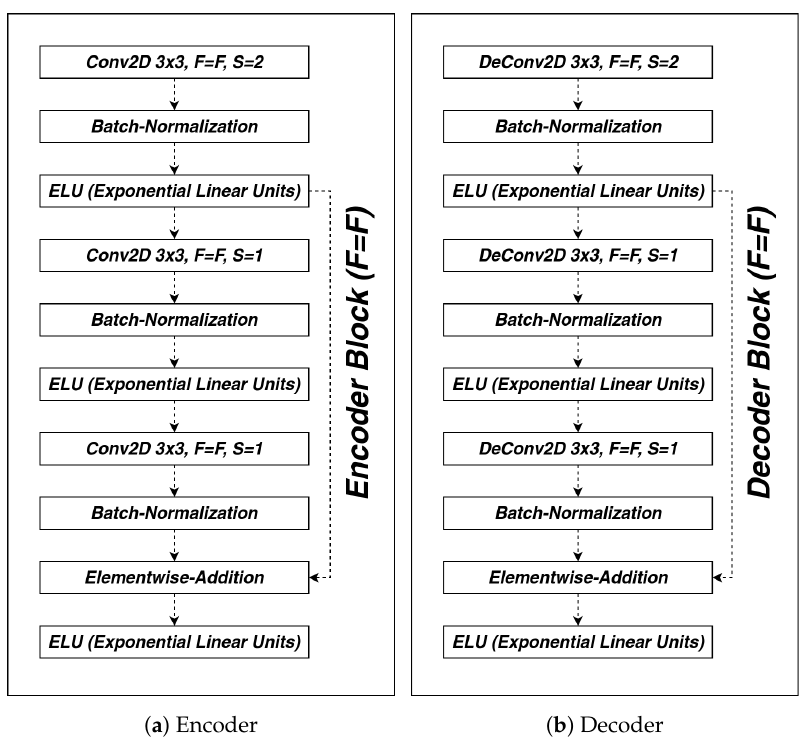
Figure 10. The encoder and decoder block of the MFD attention